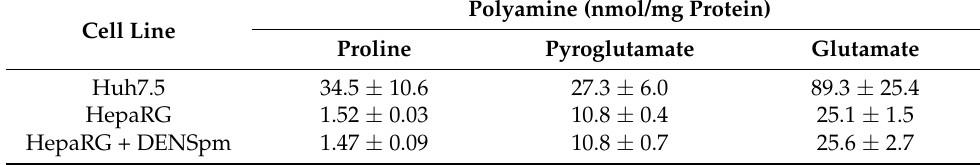
Table 2. Amino acid levels in cell